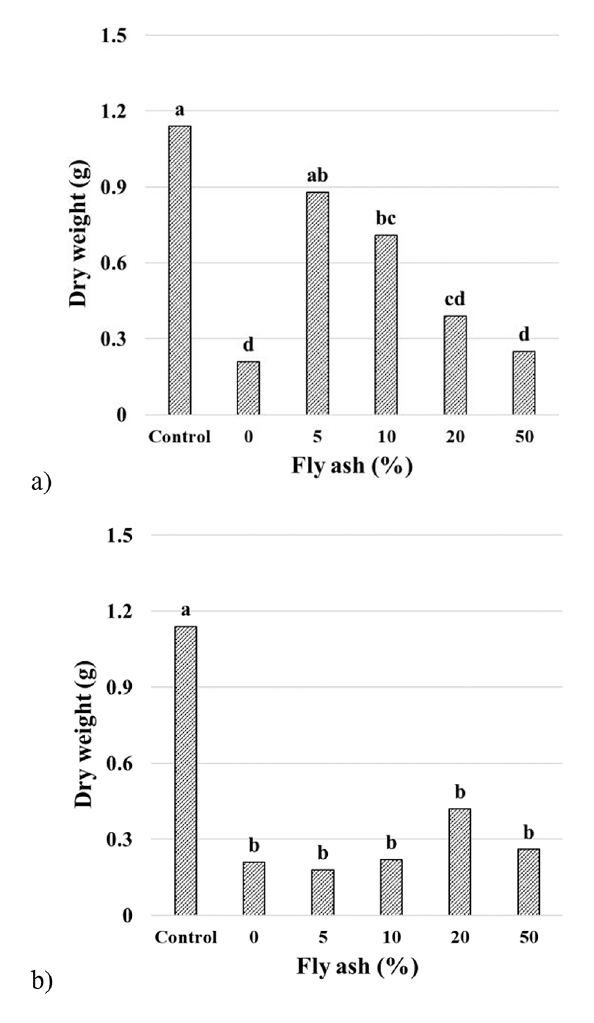
Fig. 3 Dry weight of Acacia mangium : a Acidic soil 1, b Acidic soil 2